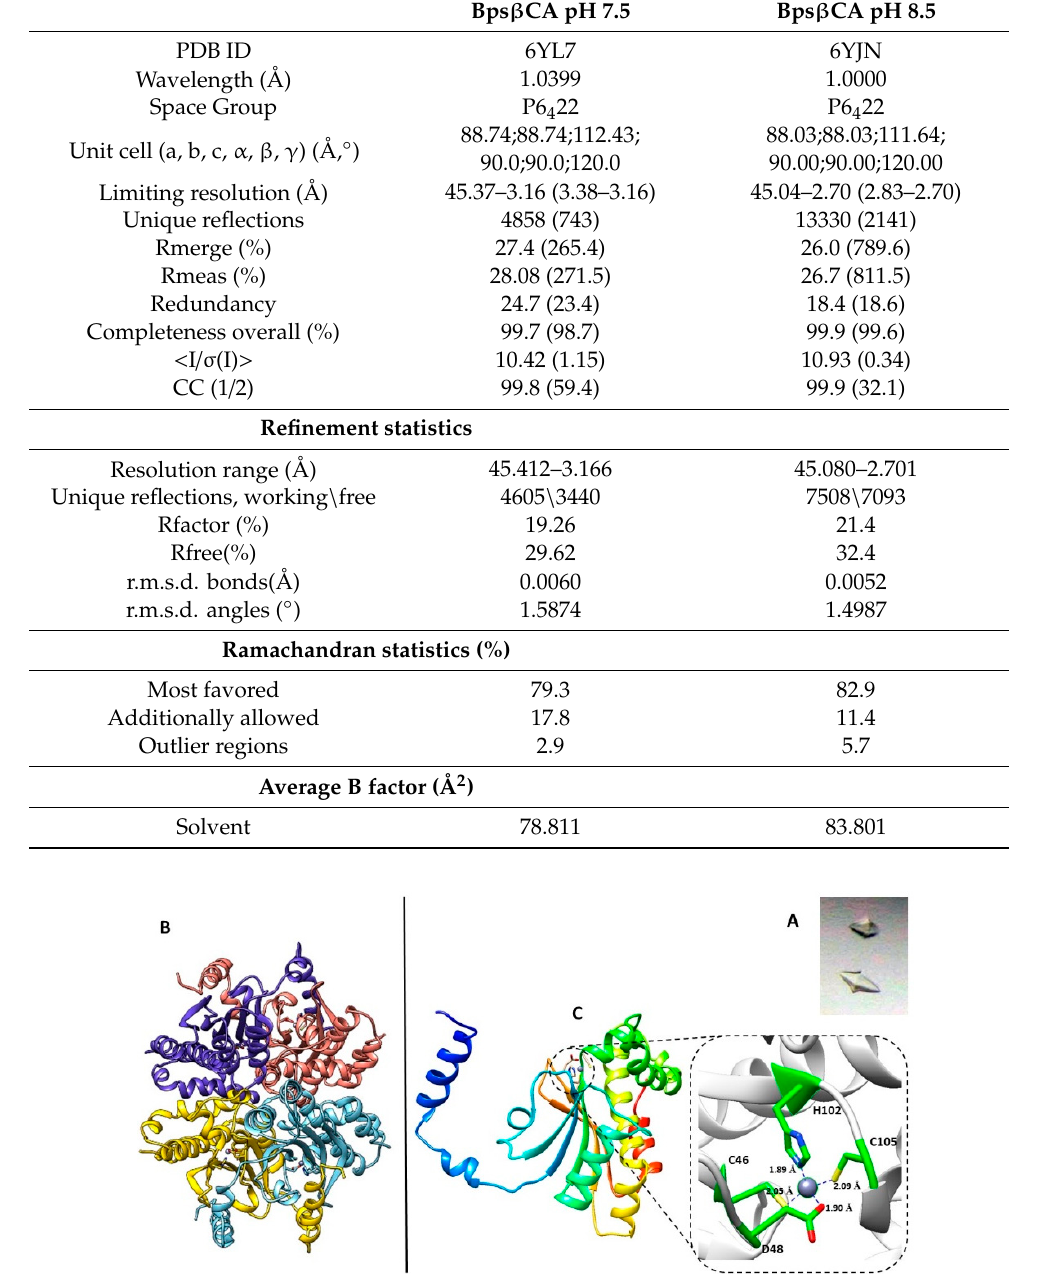
Figure 1. ( A ) The shape of Bps β CA crystals, under bright field illumination. ( B ) Ribbon diagram showing the tetrameric arrangement of Bps β CA. ( C ) Crystal structure of Bps β CA. Ribbon diagram of the Bps β CA structure, asymmetric unit content, and active site of Bps β CA. The detailing insert shows the enzyme active site with the zinc ion (gray sphere) and its ligands (Cys46, His102, Cys105, and Asp48).